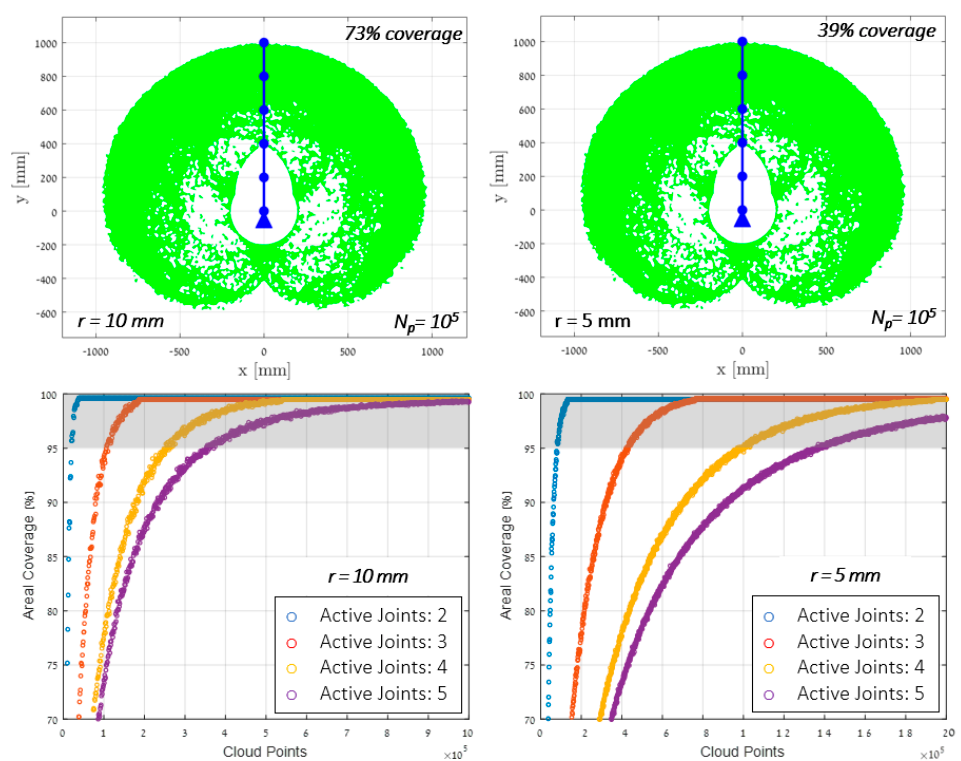
Table 2. Criteria for the number of cloud points to generate to achieve 95% and 98% area coverage for a cover radius of 5, 10, and 15 mm.